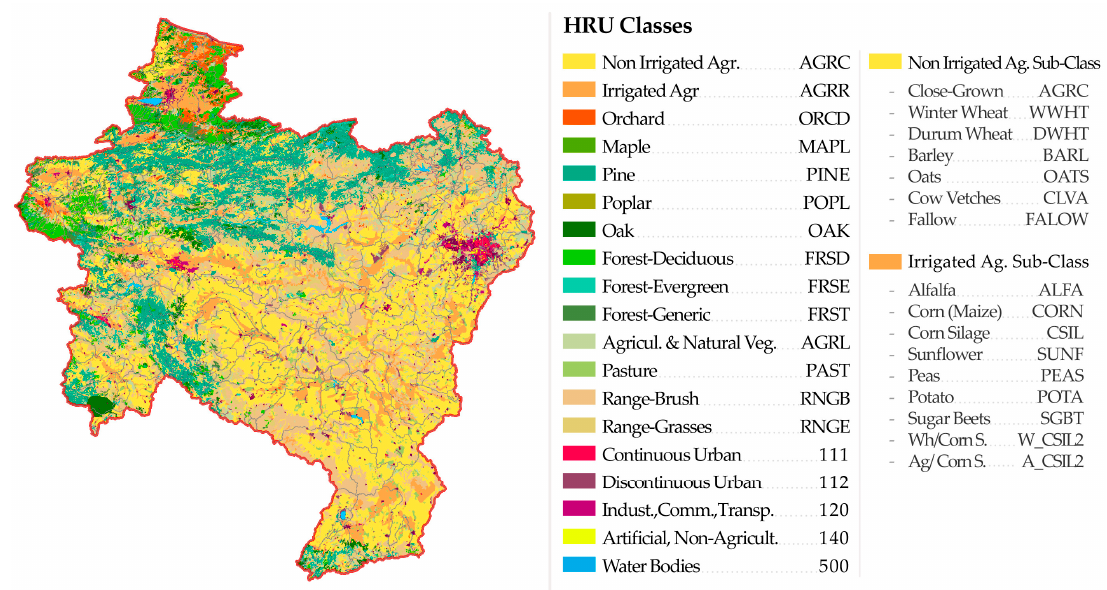
Figure 6. Hydrological Response Unit classes in the Sakarya River Basin.